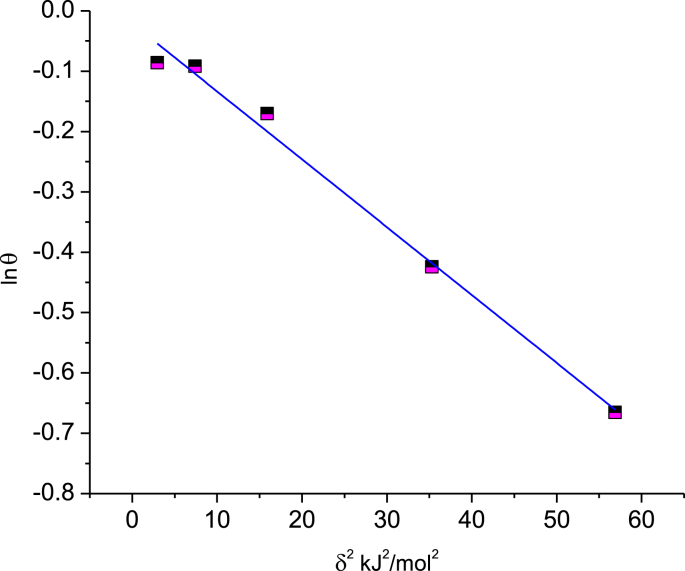
Dubinin–Radushkevich Isotherm plot for adsorption of BQYP molecules on mild steel in 2 M H2SO4 at 298 °K.